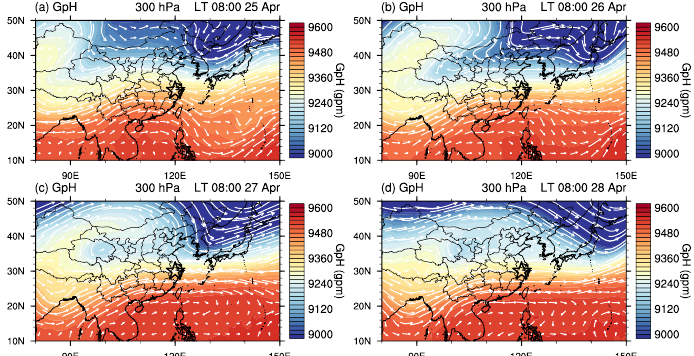
Figure 4. Spacial distribution of geopotential height (shading) and horizontal winds (arrows) at 300 hPa over east Asia from 25 April 2018 to 28 April 2018. The geopotential height and horizontal winds data are from ERA5. The black star in each panel indicates the area of interest in this